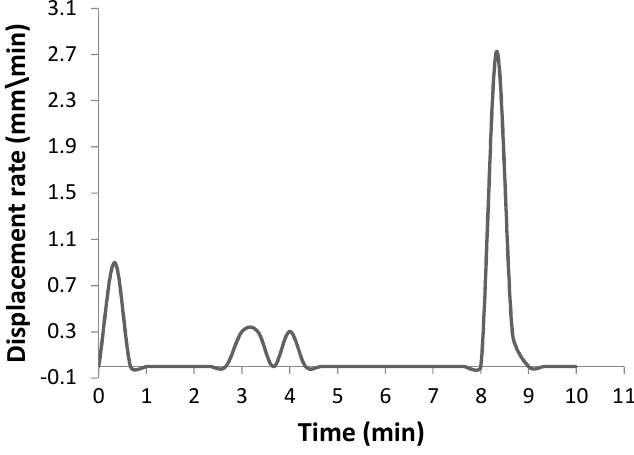
Figure 3. Displacement changes vs sintering time for SPS sintering.